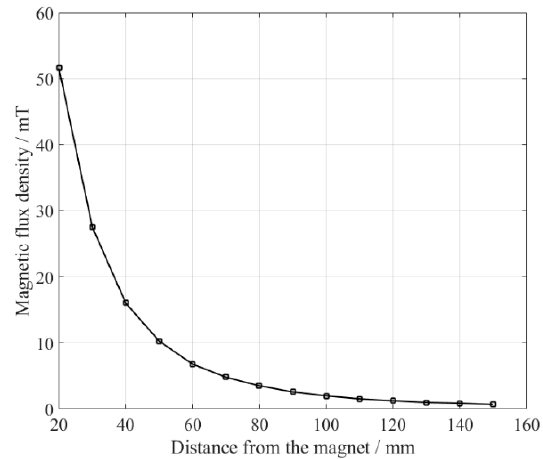
Figure 12. Magnetic flux density at different distances from the permanent magnet.